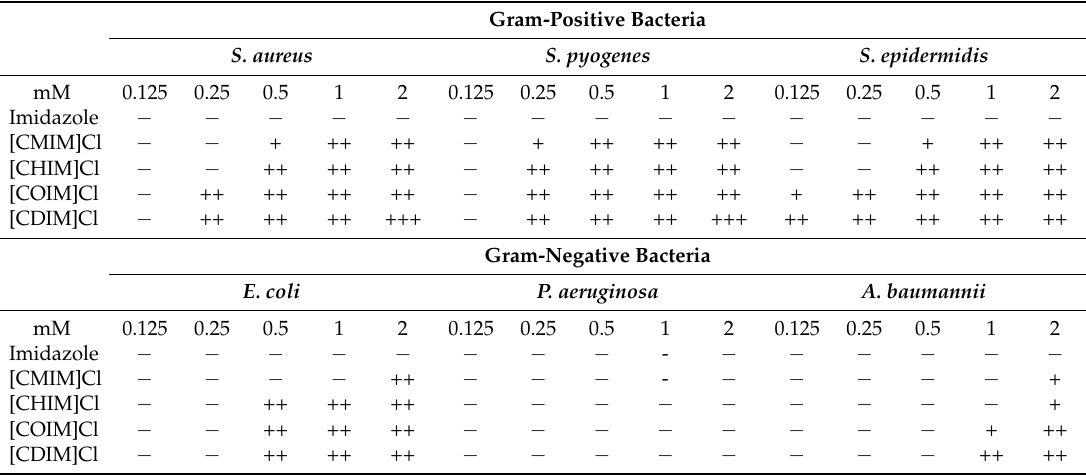
Table 2. Bacterial growth inhibition halos (mm) at different ILs concentrations in agar well diffusion assay.